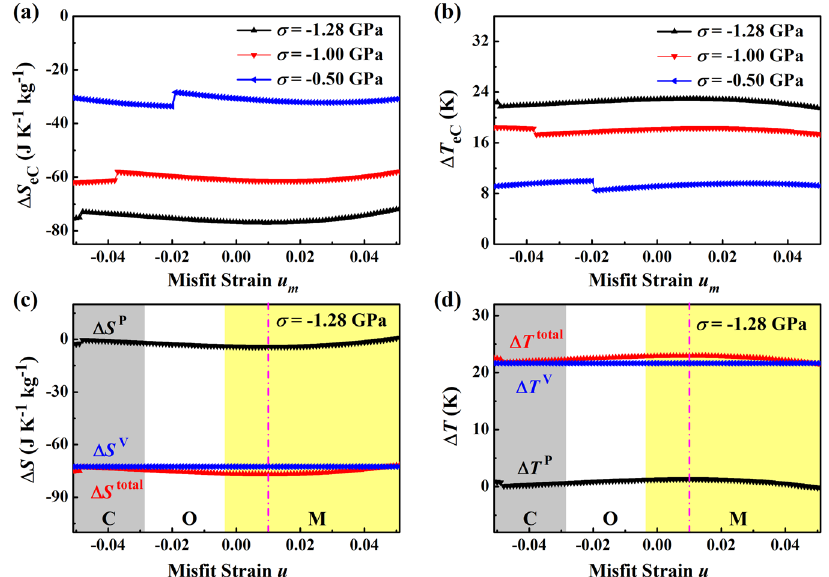
Fig. 4 Contributions of the eC performance of the [MDABCO](NH 4 )I 3 thin fi lm. a The eC entropy change Δ S eC and b the eC temperature change Δ T eC for [MDABCO](NH 4 )I 3 thin fi lm versus with mis fi t strain ( u m ) under different external stresses. The contributions of polarization change and volume change under a compressive stress of 1.28 GPa for c the eC entropy change and d the eC temperature change Δ T eC . The gray, white, and yellow regions mark different phases. The pink dash lines mark the maximum eC Δ S eC and Δ T eC at a stress of − 1.28